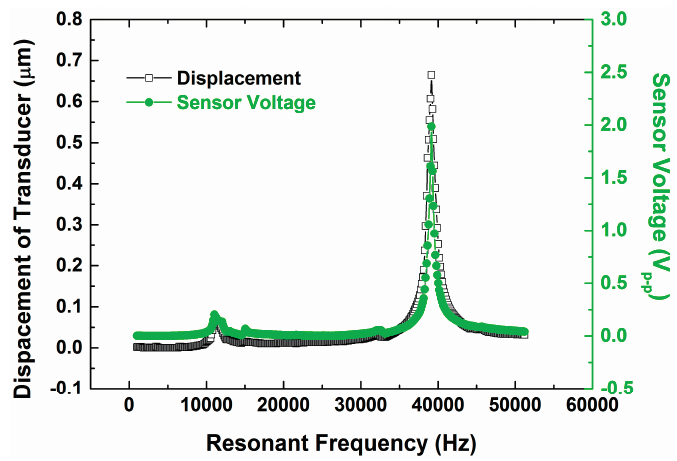
Figure 5. Frequency response under a driving voltage 5 V.